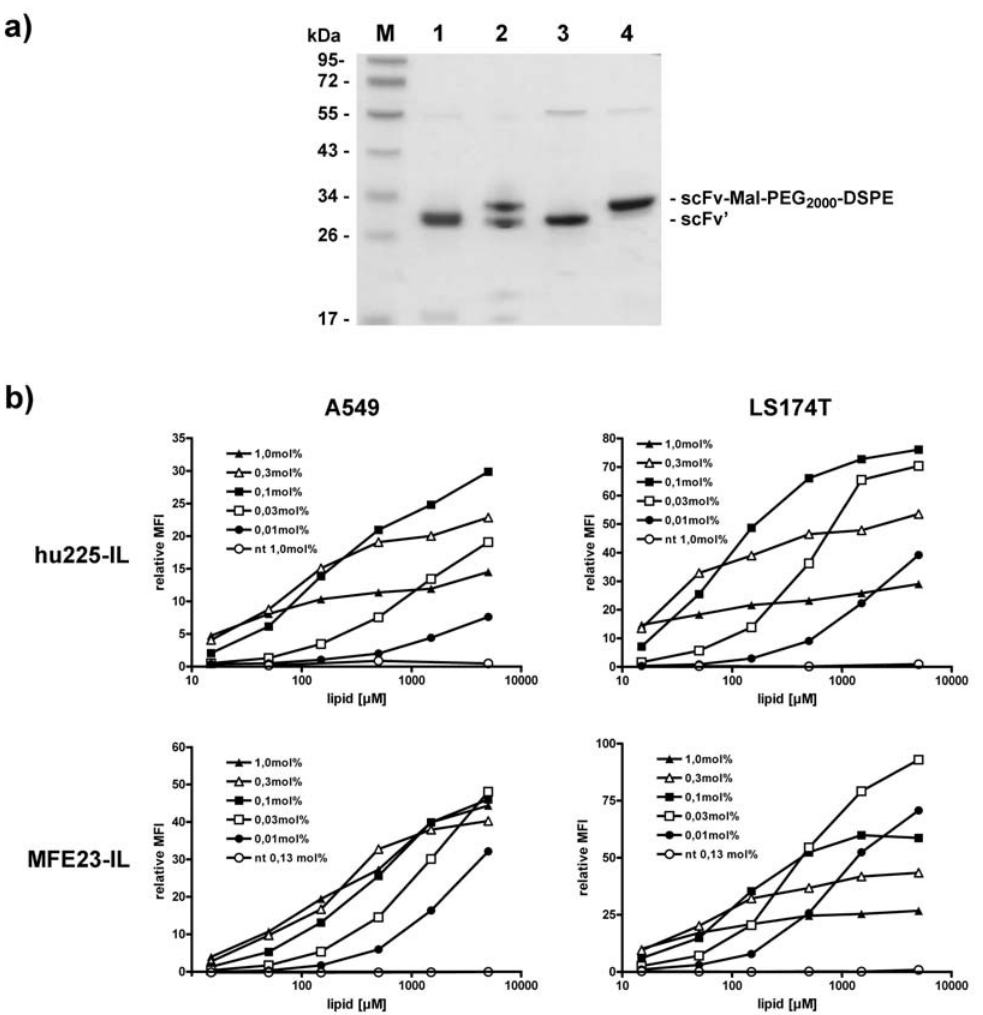
Figure 4. Generation and analysis of monospecific immunoliposomes. ( a ) Coupling efficiency of scFv' hu225 and MFE23 to Mal-PEG under reducing conditions. 1, scFv' MFE23; 2, scFv' MFE23 coupled to Mal-PEG DSPE micelles; 3, scFv' hu225; 4, scFv' hu225 coupled to Mal-PEG ( b ) Binding of hu225-IL and MFE23-IL to A549 and LS174T